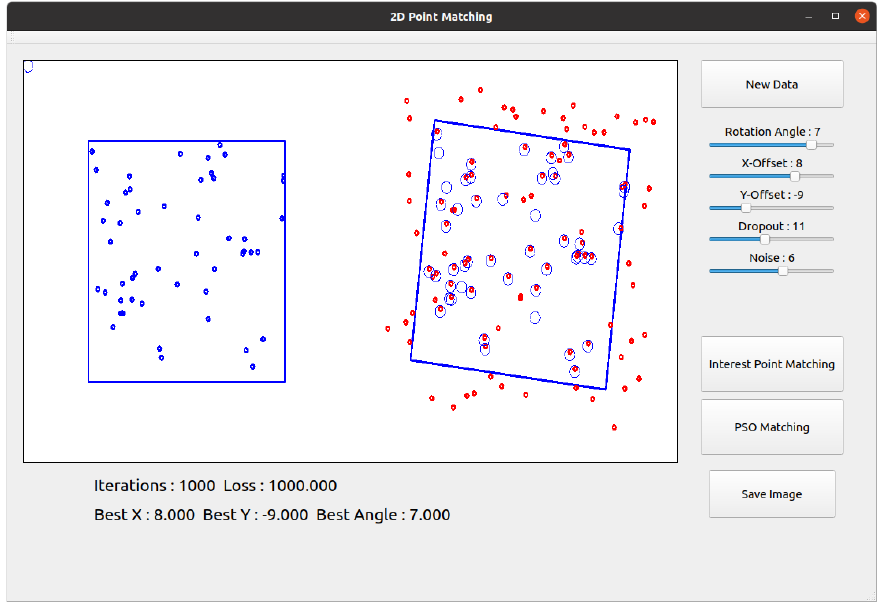
Figure 8. The 2D point cloud matching